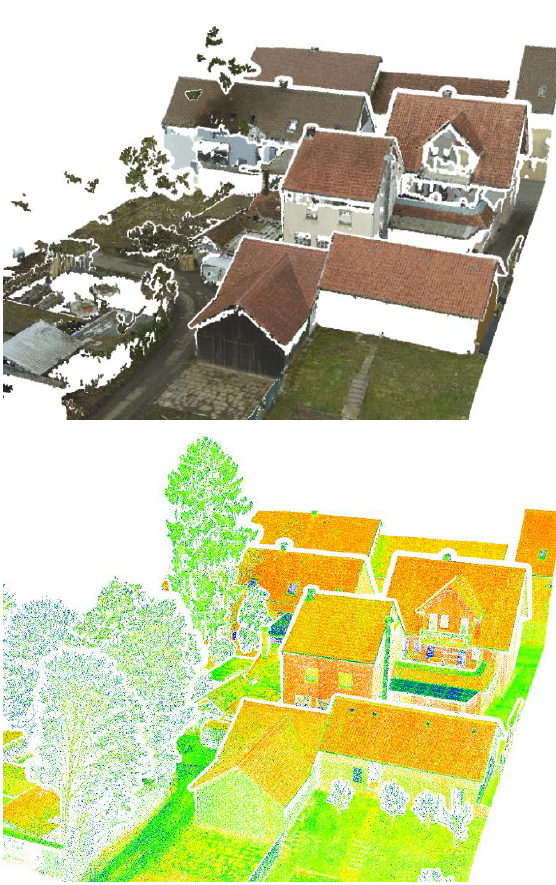
Figure 5. Comparison of photogrammetric ( top : RGB colorized) and LiDAR point cloud ( bottom : colorized by reflectance – blue = low, red =